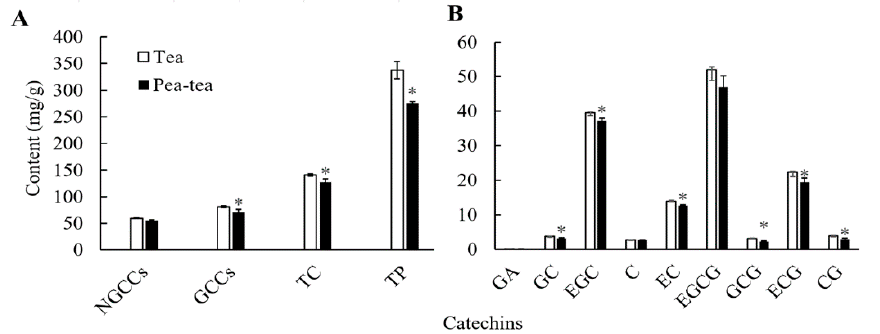
Figure 1. Tea catechins in new shoots from pea-tea intercropping plants. Asterisks * represents sig-